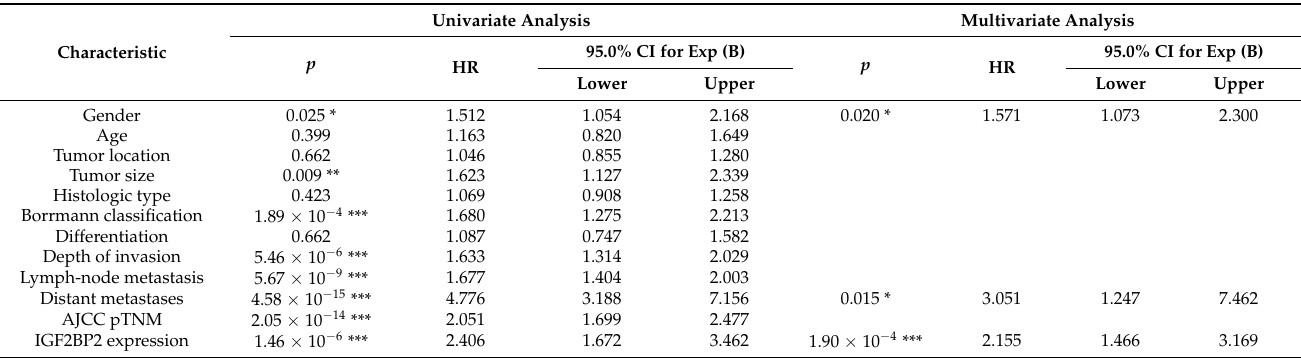
Table 2. Overall survival analyzed through Cox proportional-hazard regression.